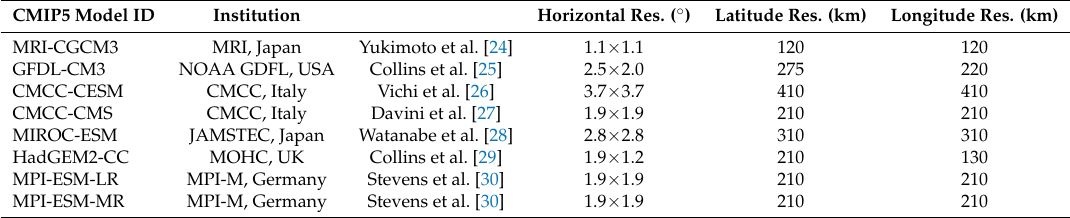
Table 1. List of the Climate Model Intercomparison Project Phase 5 (CMIP5) models used, their respective resolutions (third column), and their resolutions in km at the equator (fourth and fifth